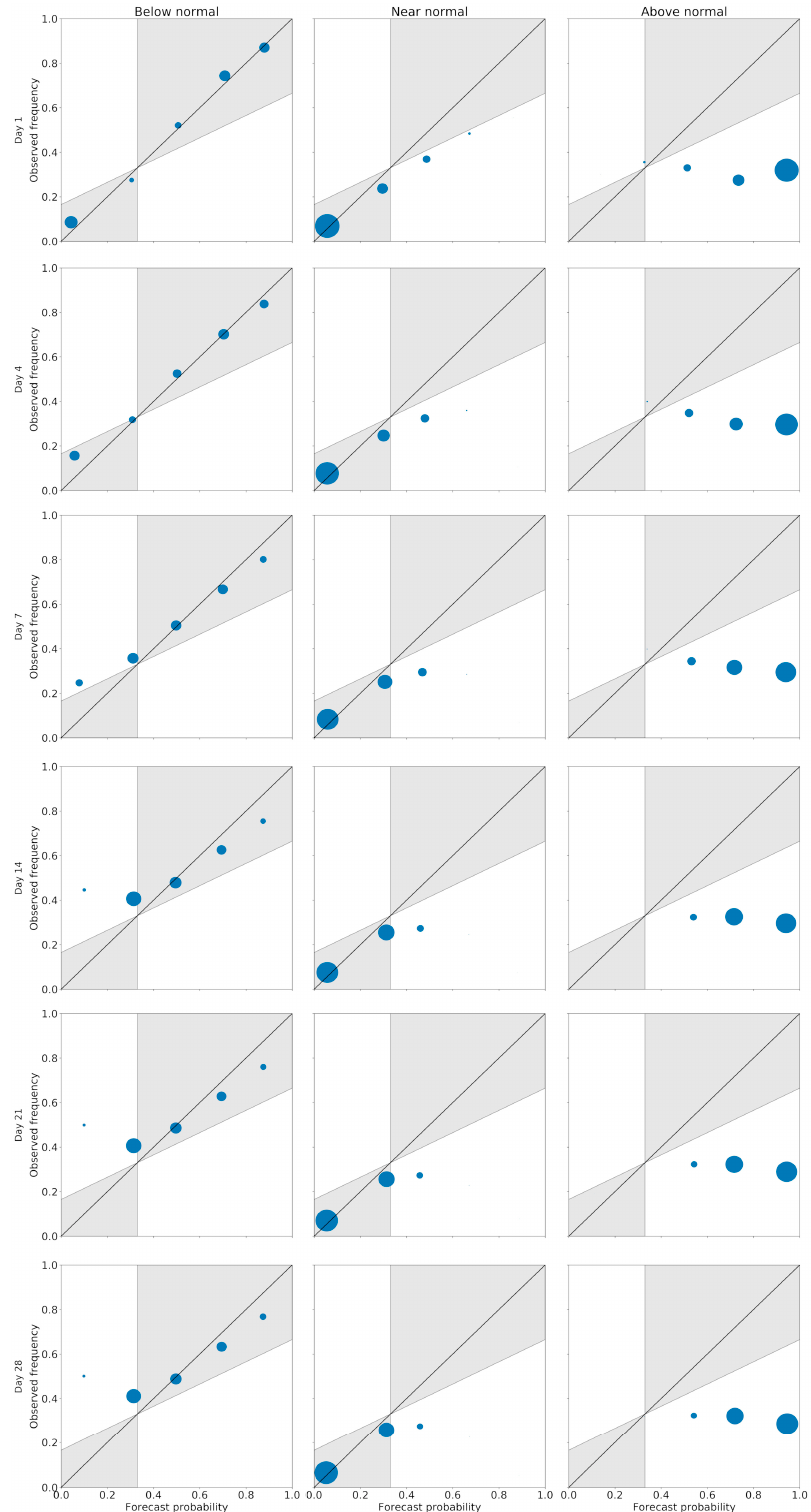
Figure 11. Attribute diagram of daily forecasts at different lead times (Day 1, 4, 7, 10, 14, 21, 28) of the MME model over China during the boreal summer monsoon for tercile based categorical probabilistic forecasts. Forecast probability is binned with width of 0.2, and the size of the dots indicates the sharpness of probabilistic forecasts.